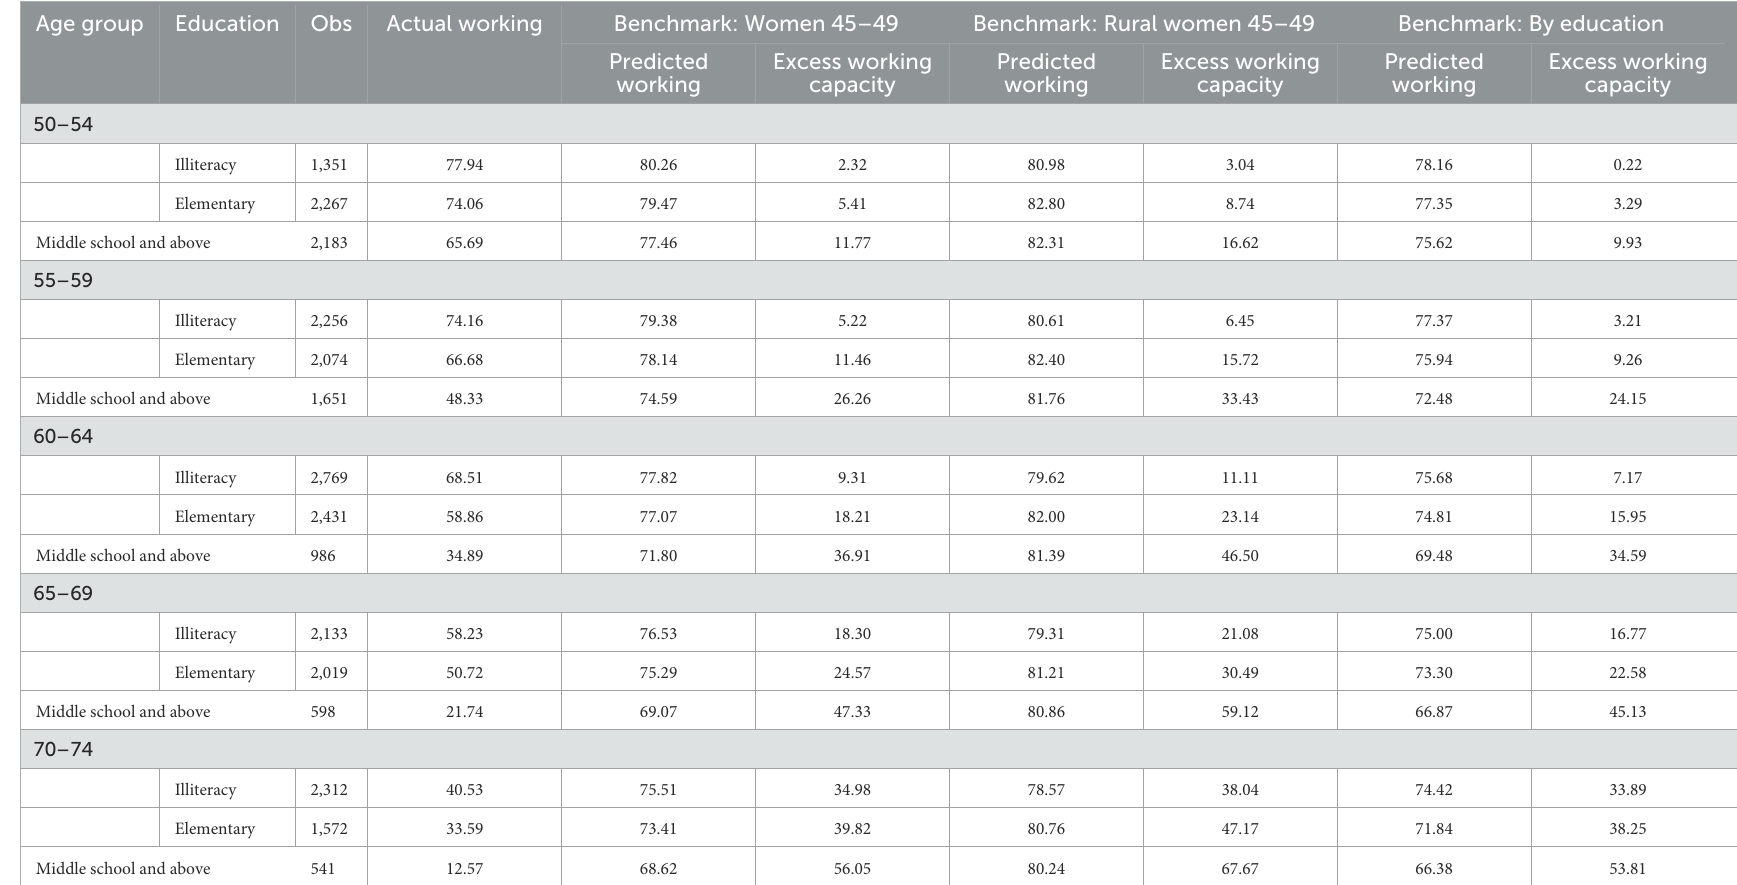
TABLE 6 Excess work capacity of women with different education levels